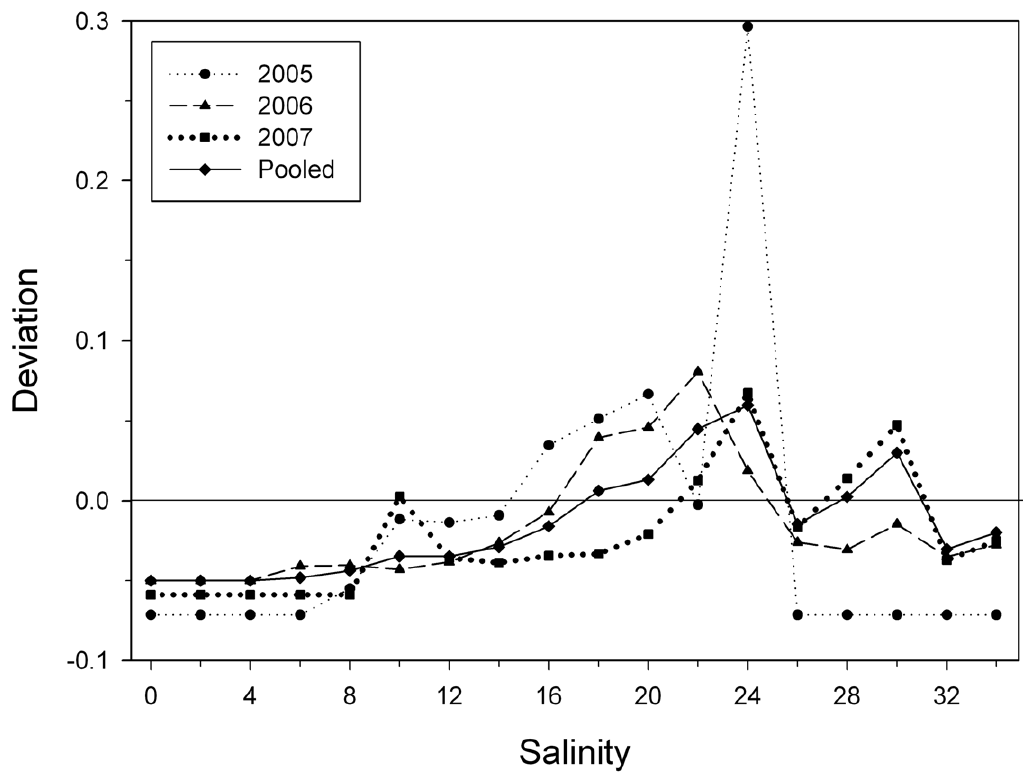
Figure 7. Salinity electivity of Pristispectinata in the Caloosahatchee River estuary revealing a preference for salinities from 18 to at least 24 psu. Sample sizes above 24 psu were small, limiting the ability to make conclusions.